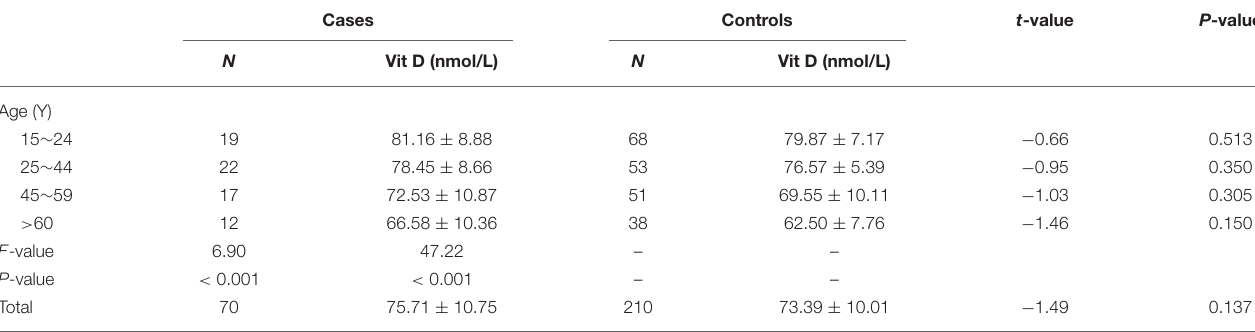
TABLE 2 | The distributions of vitamin D level in case and control population stratified by